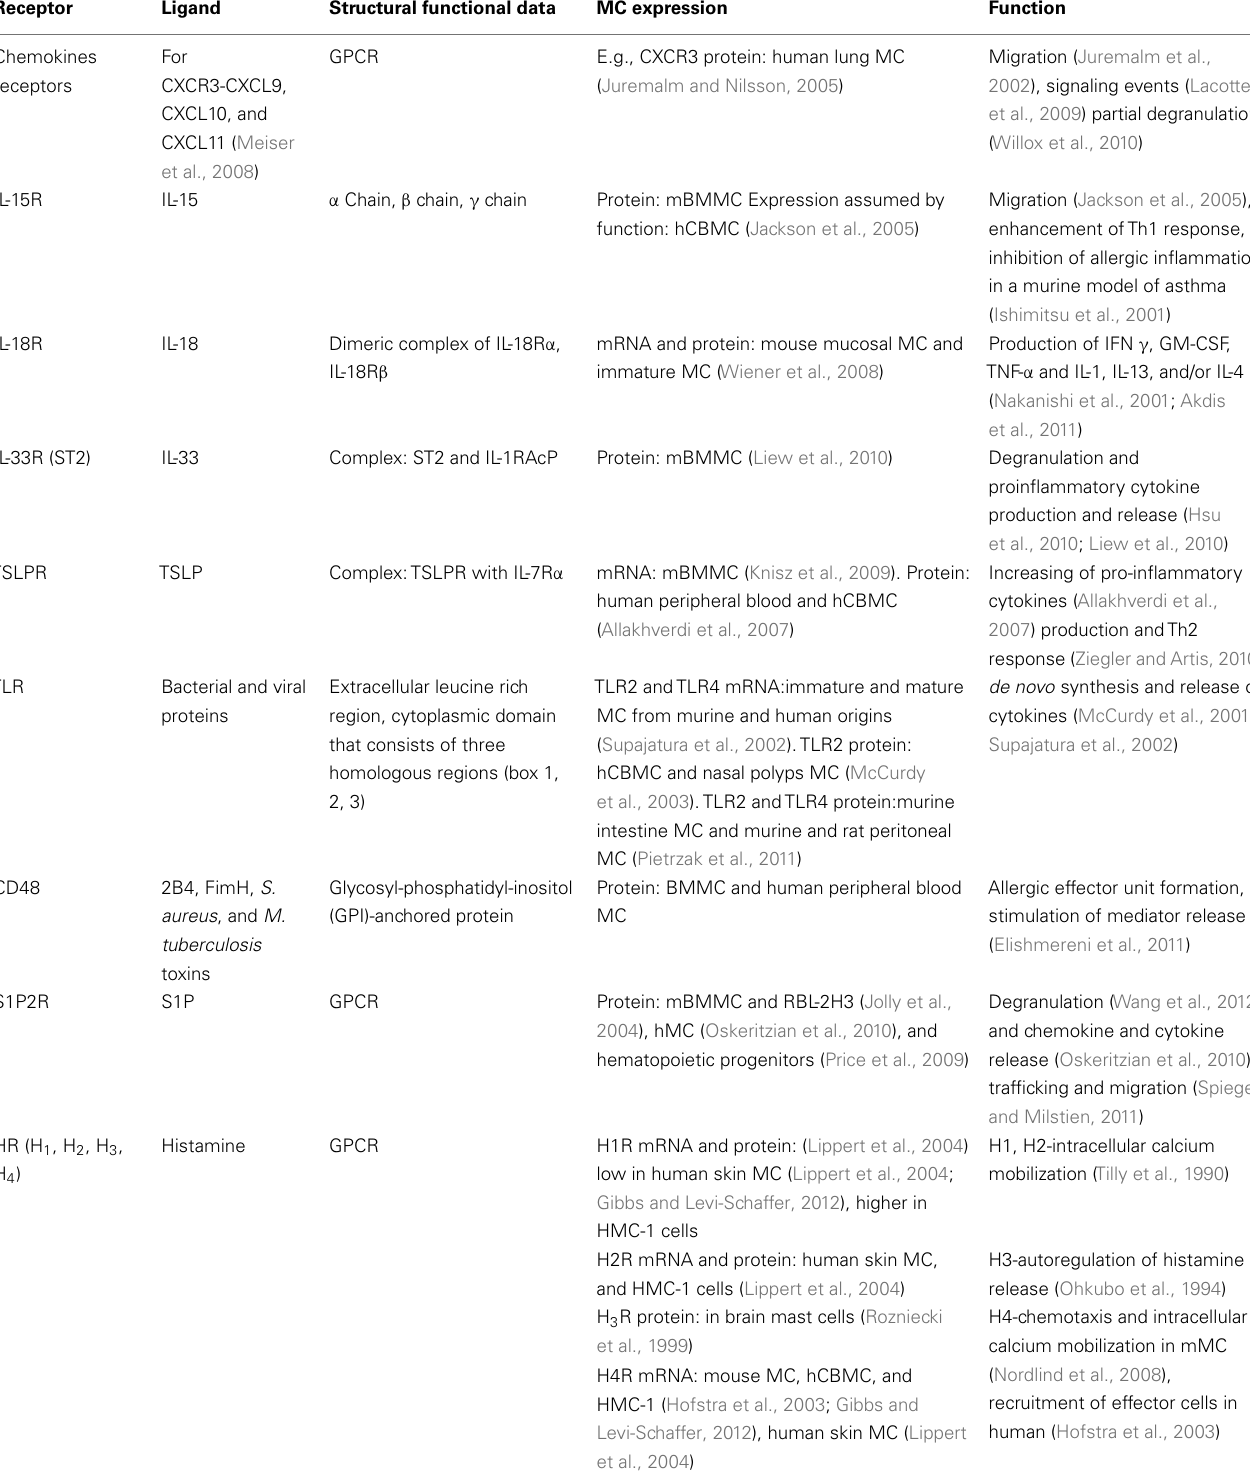
Table 1 | Structural functional data, expression, ligand, and function of some MC receptors discussed in the review.